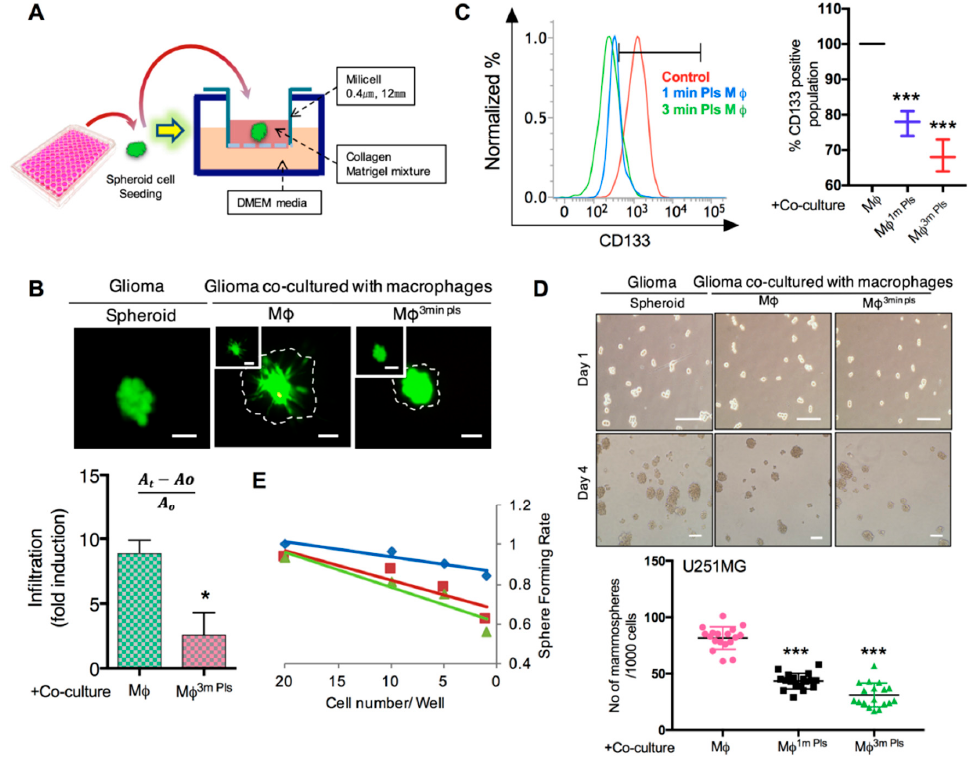
Figure 6. Co-culture e ff ect on cancer-stem-cell maintenance. ( A ) Diagram displaying the set up for